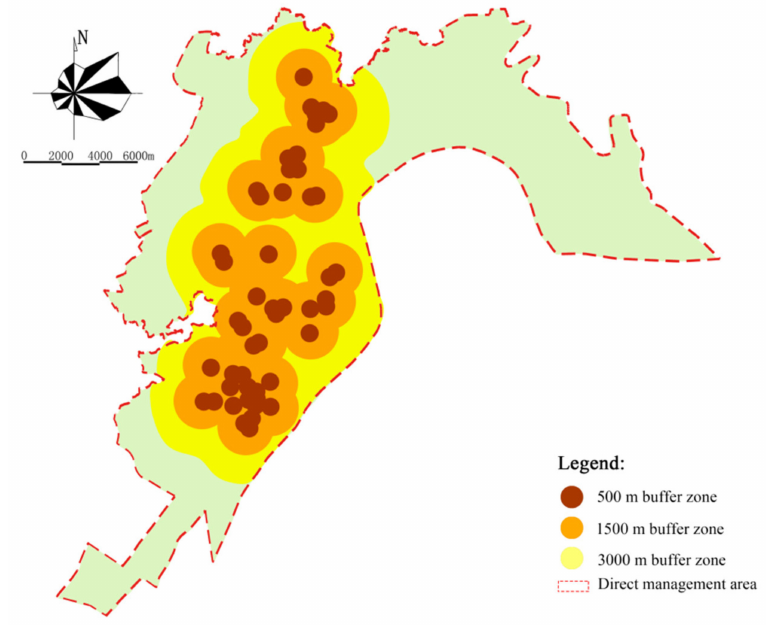
Figure 8. Multi-ring buffer zone analysis of spatial